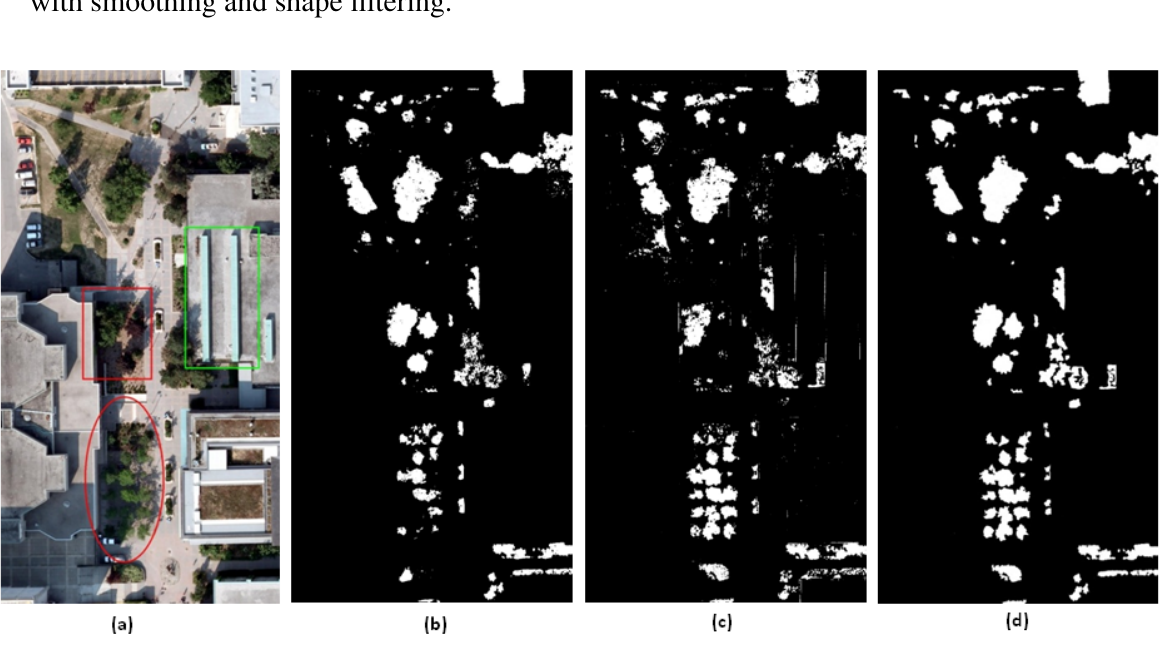
Figure 3. From left to right ( a ) the true color original image with location indication; ( b ) the NDVI filtering image; ( c ) the GI filtering image; ( d ) the NDVI+GI merged image with smoothing and shape